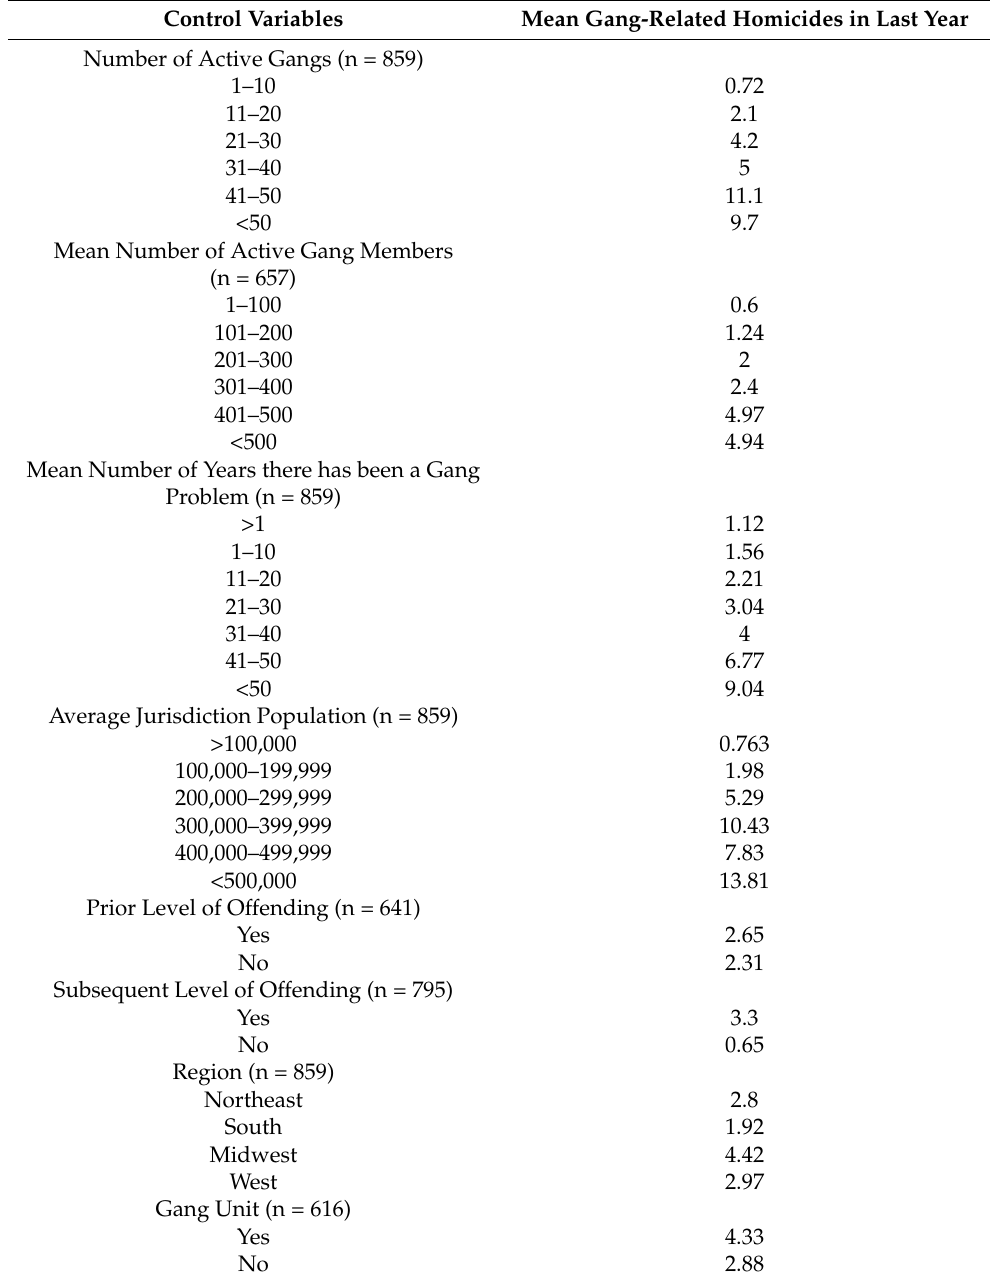
Table 1. Control Variables Descriptives (N = 859) 2